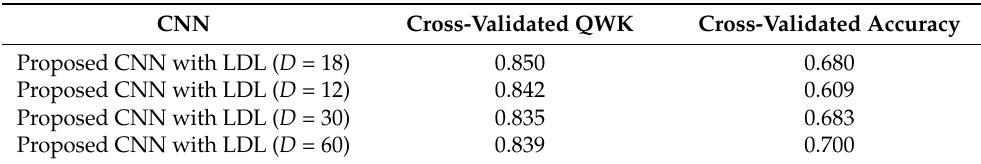
Table 4. Results of the five-fold cross validation of the proposed CNNs with different D values (EfficientNet B3 only).